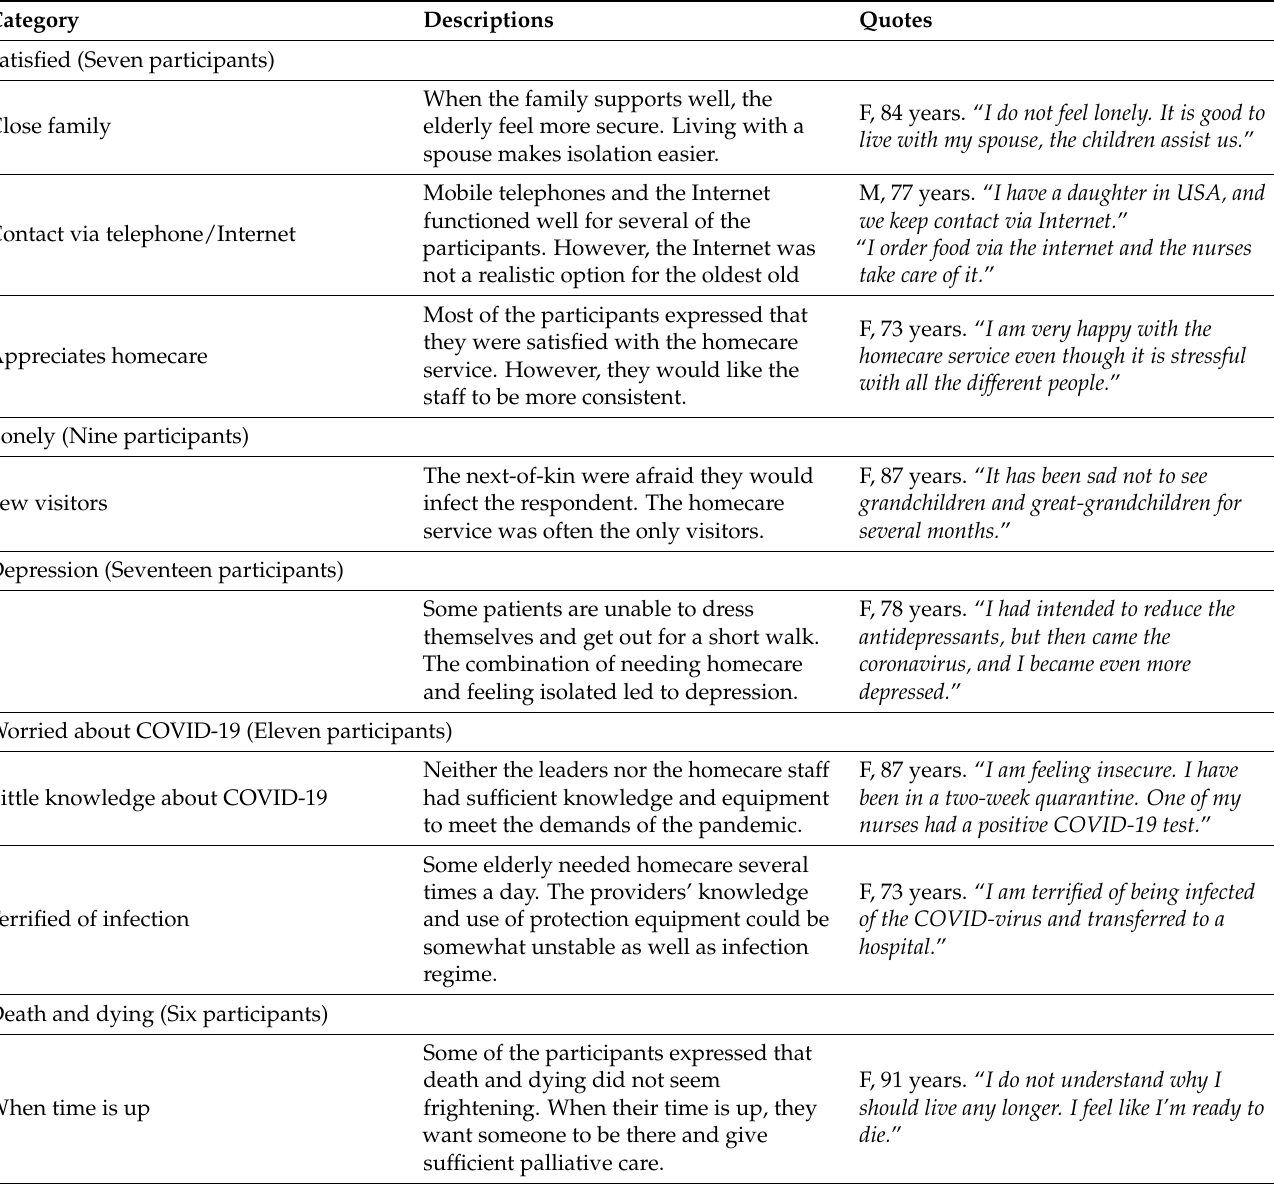
Table 2. Central categories, descriptions, and